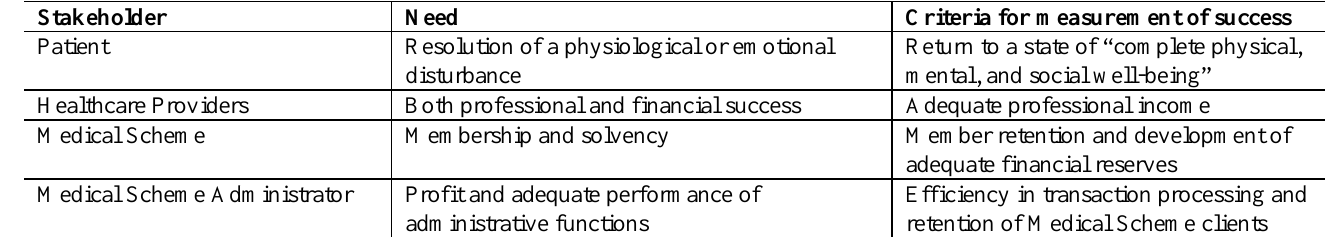
Figure 2. Role player needs